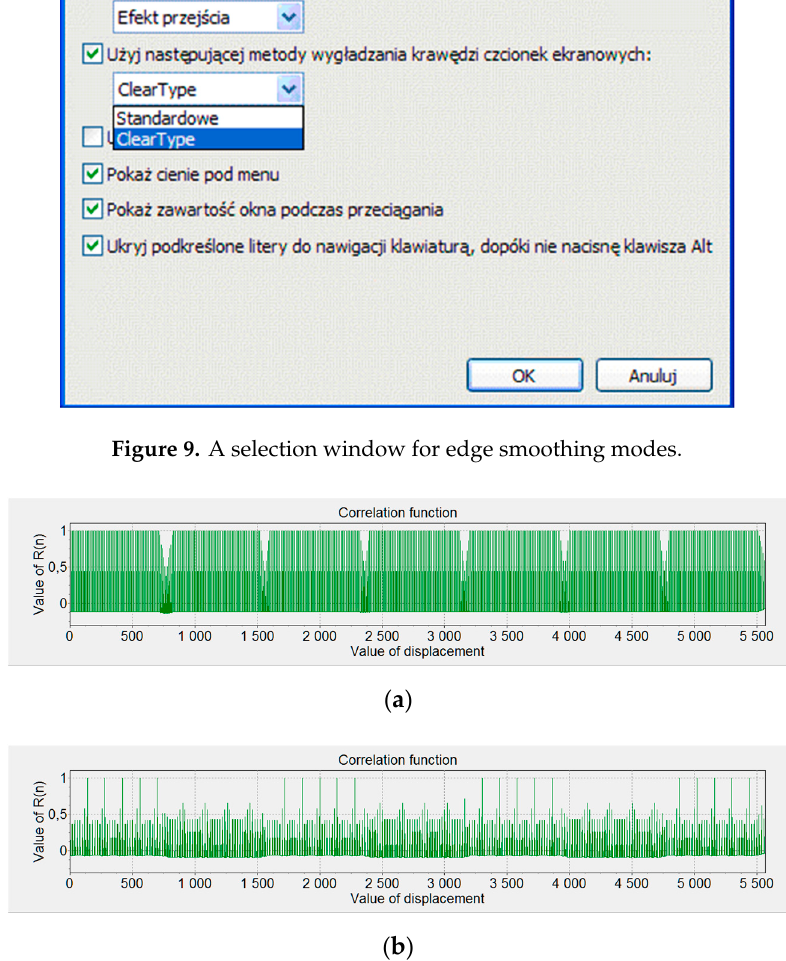
Figure 10. The courses of correlation function R (n) for selected color pairs in grayscale: ( a ) 238 × 8, ( b ) 255 × 0.